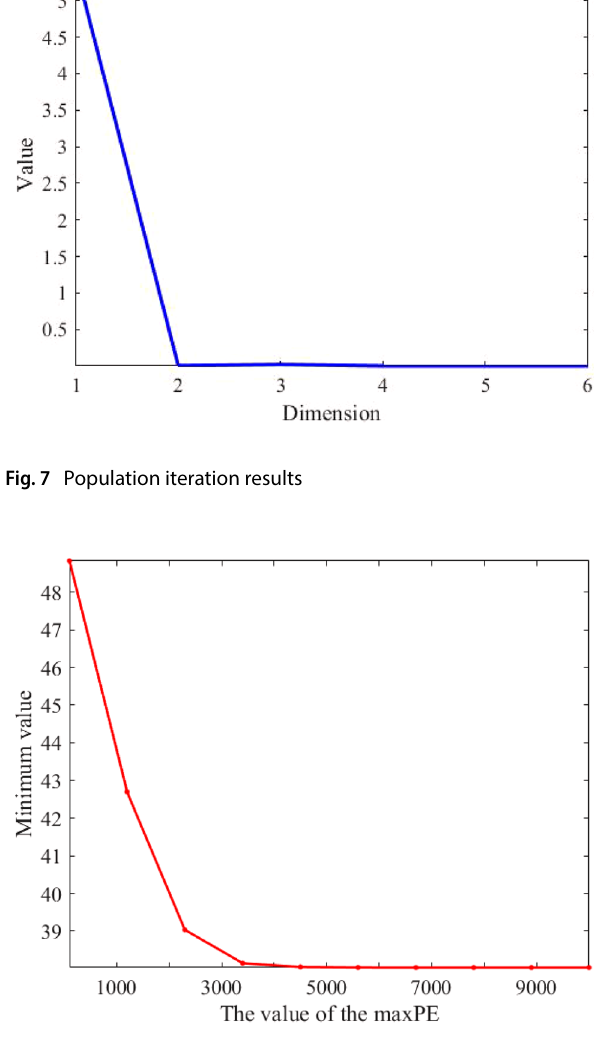
Fig. 8 Value of fitness function of